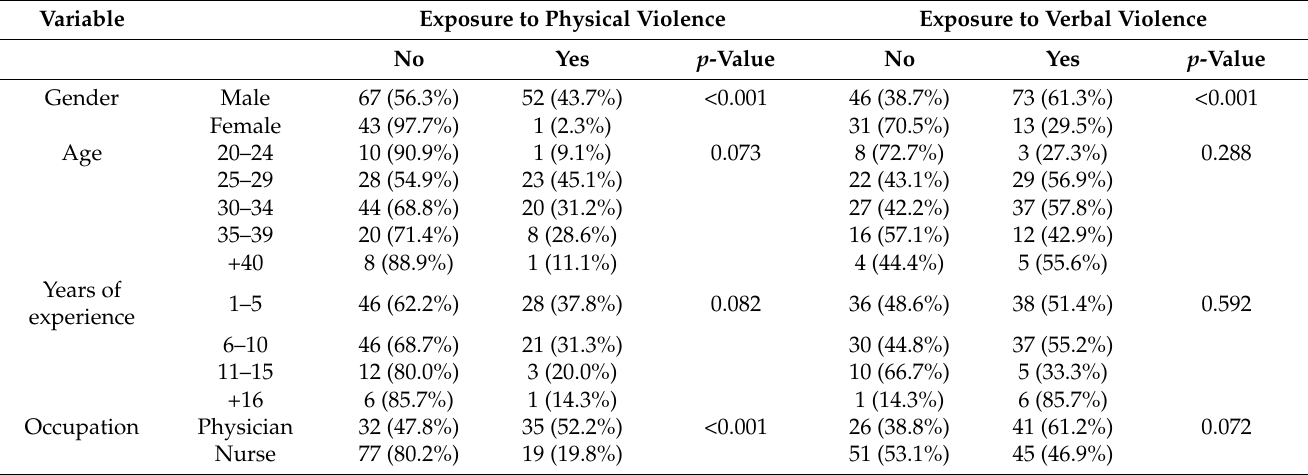
Table 2. Exposure to physical violence according to the characteristics of respondents (n = 163).